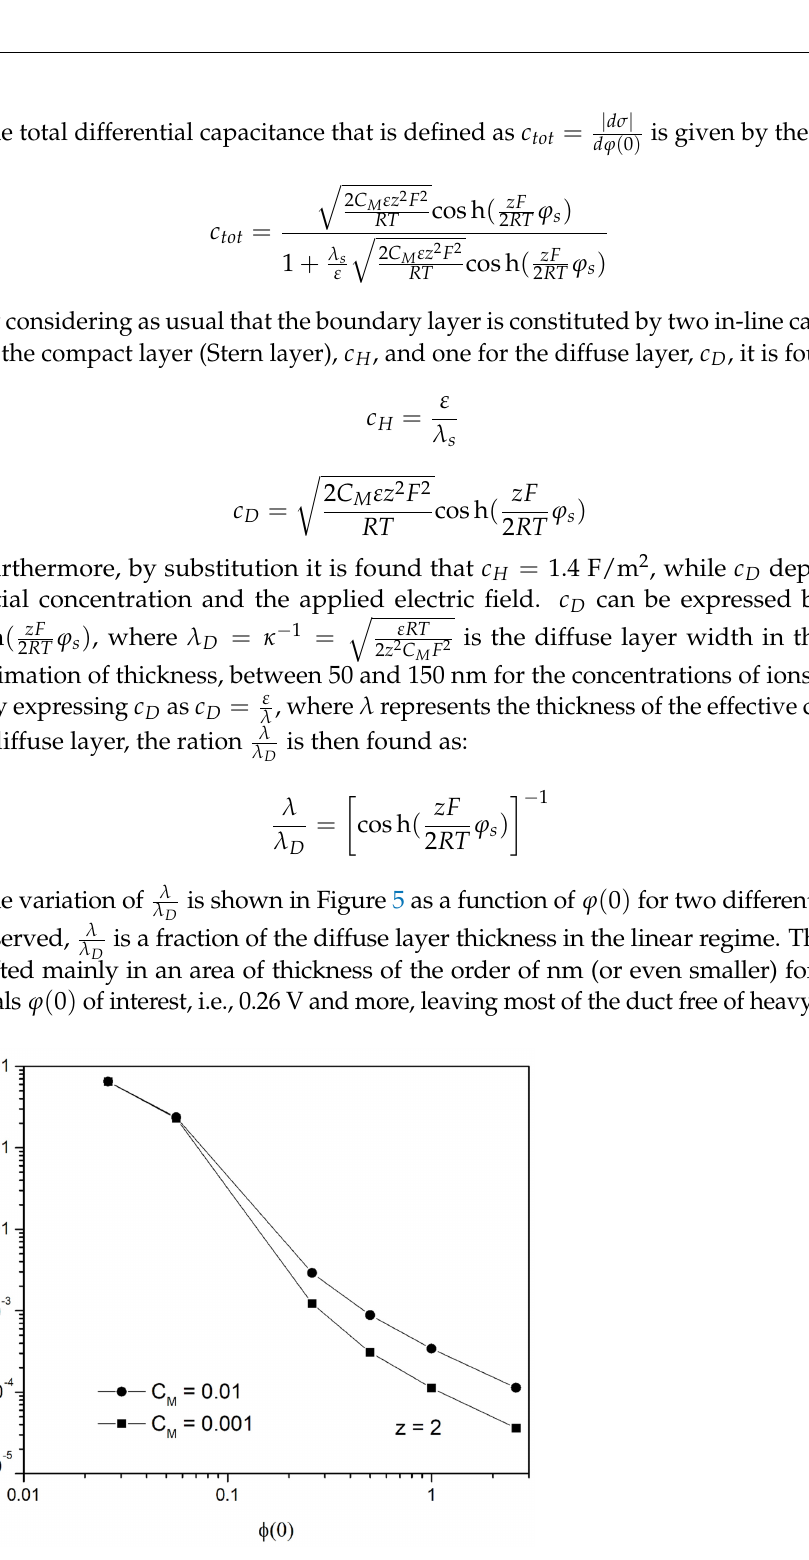
Figure 5. Ratio of (cid:3090) for 𝑧 = 2 ions as a function of 𝜑(0) (V) for 𝐶 (cid:3014) = 0.001 (cid:2923)(cid:2925)(cid:2922) (cid:3090) (cid:3253) 0.01 (cid:2923)(cid:2925)(cid:2922) (cid:2923) (cid:3119)